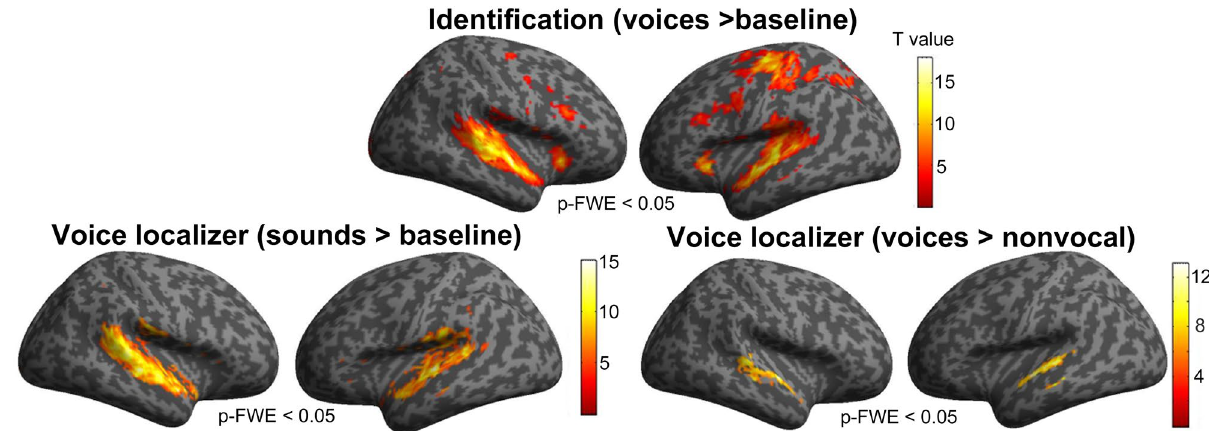
Figure 3. Univariate random effects (RFX) analysis. First row: identification task, contrast voices > baseline; second row: localizer task, contrast sound > baseline (left) and voices > non-voices (right). All contrasts are shown at p < 0.05 FWE-corrected (voxel-level), extent threshold = 0 mm 3 . The group statistical map is here overlaid on an inflated render in SPM. Coordinates (x y z) Cluster size Anatomical